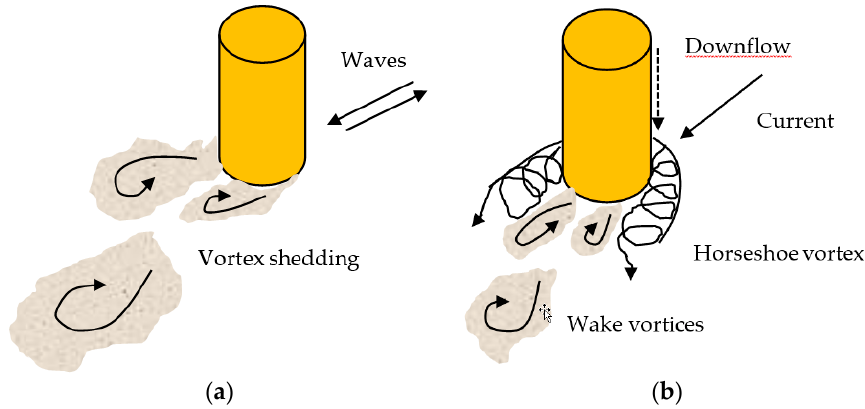
Figure 3. Pictorial view of scour hole around a vertical pier. ( a ) Scour under waves, where the vortex shedding is the main mechanism for 6 < KC < 100. ( b ) Scour under steady current, where downflow, horseshoe vortex, and wake vortices are the key mechanisms.